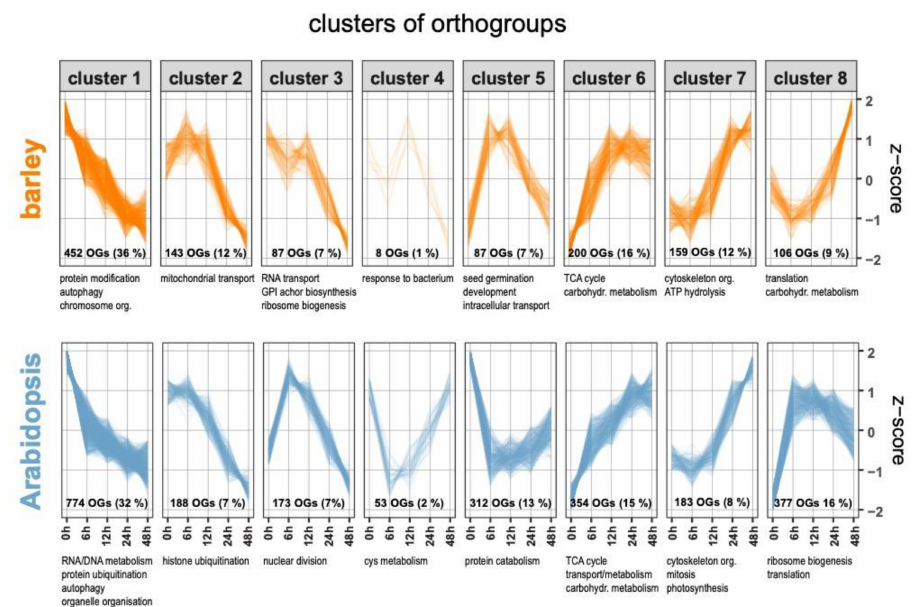
Figure 3. Comparison of transcript abundance profiles during germination in barley and Arabidopsis. For cross-species comparison of transcript abundance changes during germination, we compared changes in transcript abundance in barley to published data in Arabidopsis [10]. Genes in both species were classified into orthologous groups of genes (“orthogroups”) using OrthoFinder 2 [35] and clustered using the Clust algorithm [36]. A summary of the enriched GO terms for genes in each cluster is given below each panel, and the full list available in Table S6. The number in each panel gives the number of orthogroups in each cluster and the percentage of all orthogroups per